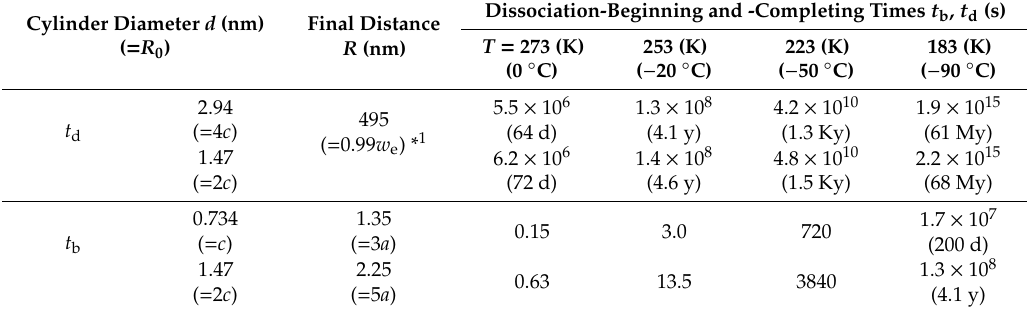
Table 4. Dissociation-beginning time t b and dissociation-completing time t d of a non-basal dislocation with Burgers vector < c + a > at temperatures T . For the parameters d , R 0 , and R , see Equations (12) and